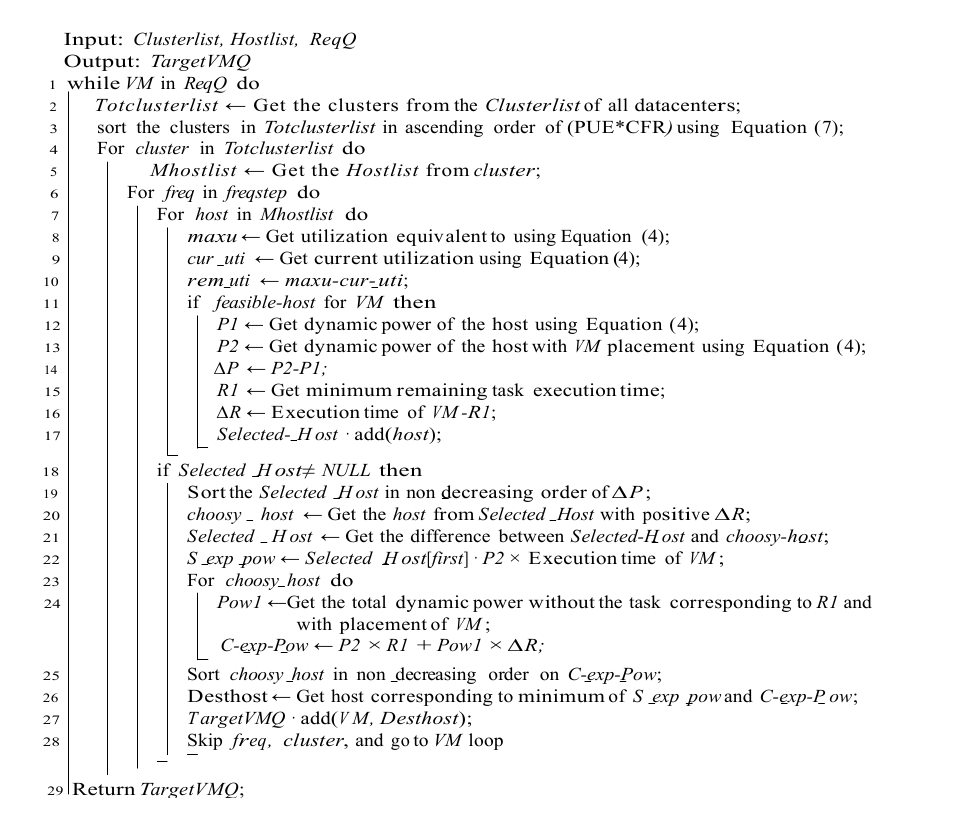
Algorithm 2: CPEF Carbon and Power-Efficient Optimal Frequency VM Placement Input: Clusterlist, Hostlist,